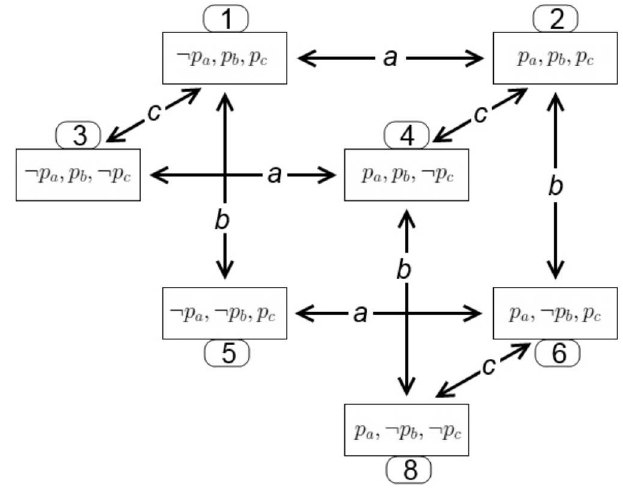
′ (model after Father’s first announcement) Figure 2. Model M